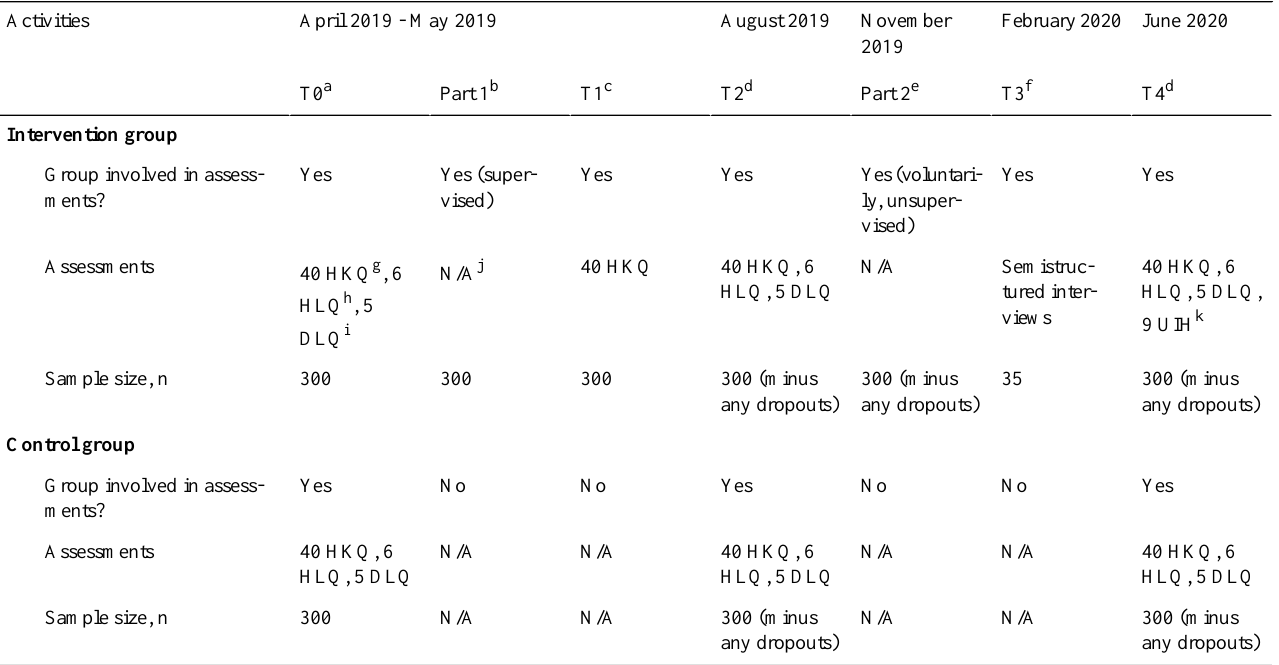
Table 1. Activities at the study sites at each time